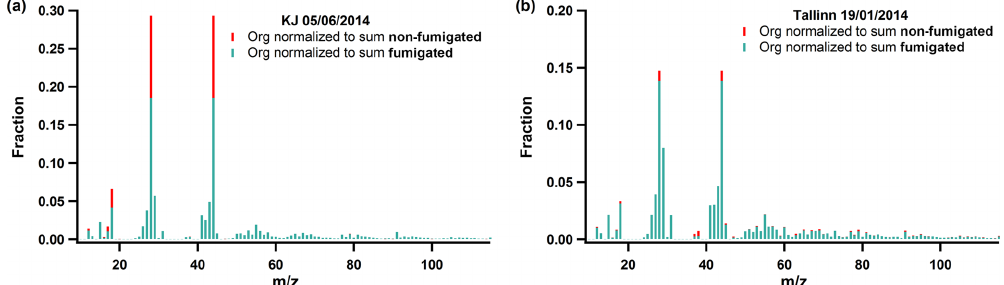
Figure 7. Example mass spectra from two fumigated and non-fumigated samples, with a high (KJ on 5 June 2014; a ), and a low dust concentration (Tallinn on 19 January 2014; b ).